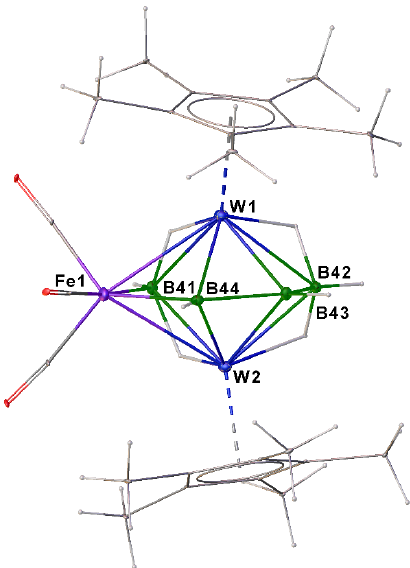
Table 1. Selected structural parameters and chemical shifts ( 1 H and 11 B NMR) of metallaboranes 1 – 5 and other related